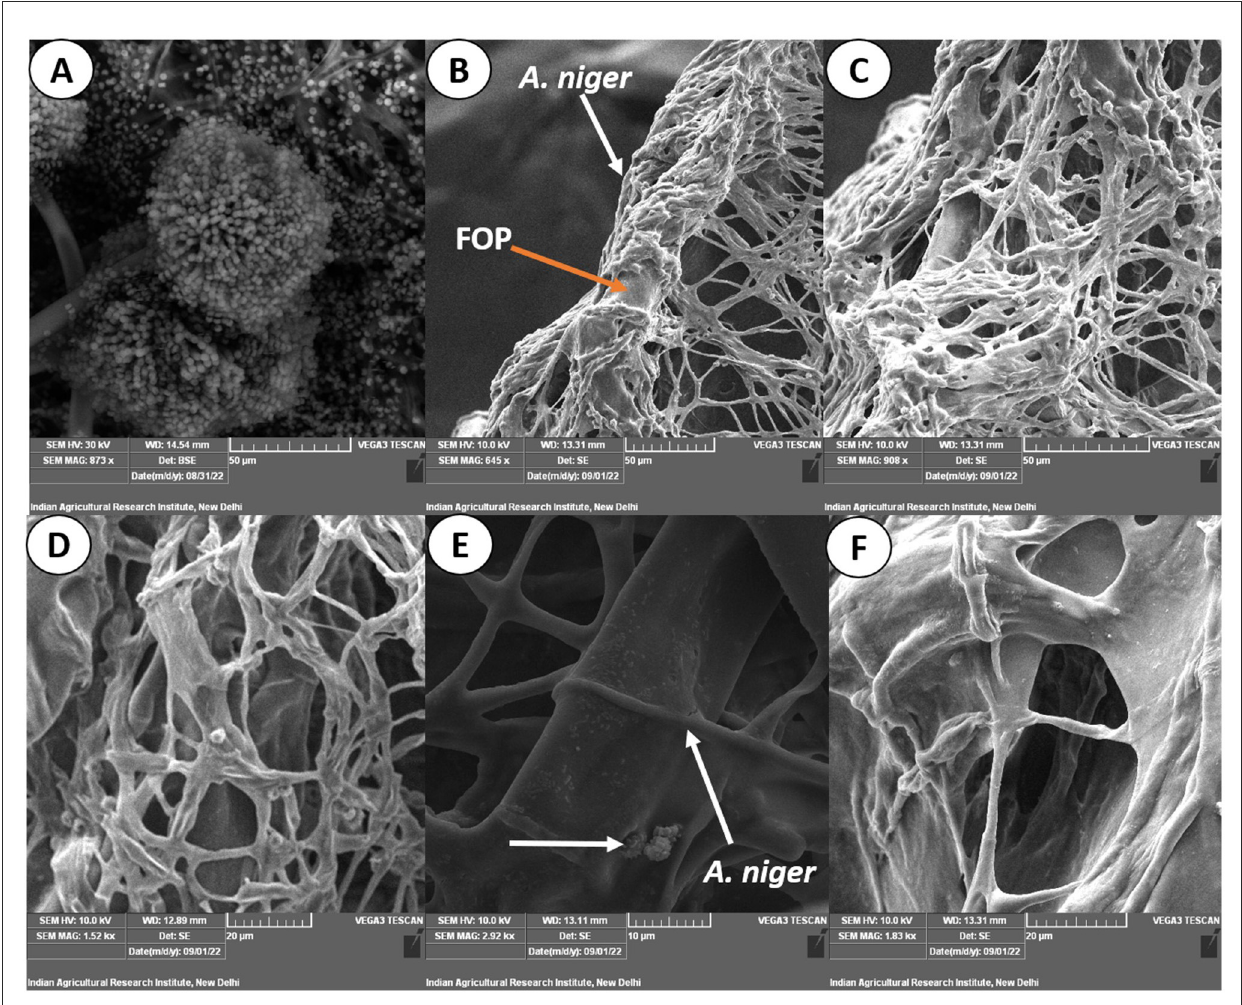
FIGURE7 Scanning electron micrograph on mycoparasitism of F. oxysporum f. sp. psidii by A. niger . (A) Fruiting body of the bio-control A. niger ; (B–D) Hyphal network of A. niger (white arrow) surrounding the pathogen hyphae (orange arrow); (E) Arrow shows coiling (pincer-like structure) and dissolution of pathogen hyphae by A. niger ; (F) Plasmolysis and death of